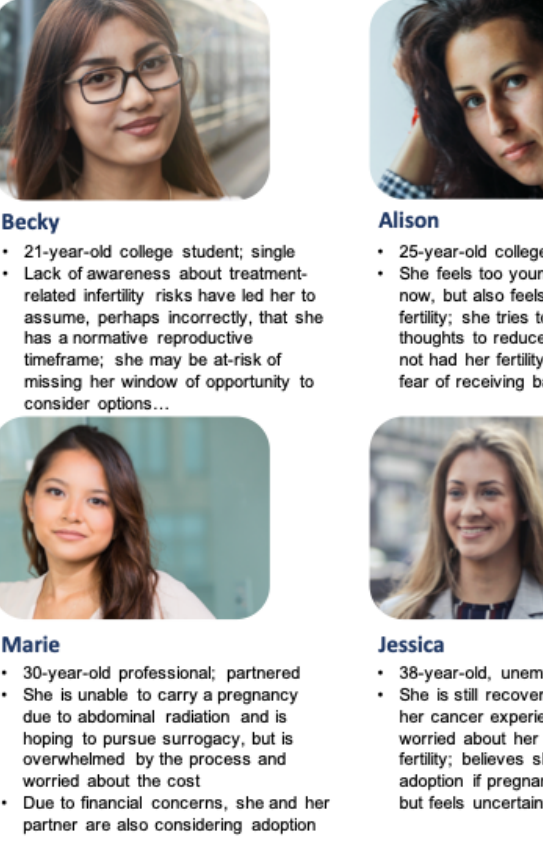
Figure 2. Personas depicting “user types” for the decision aid and planning tool website. Shortened versions of personas are depicted. IVF: in vitro